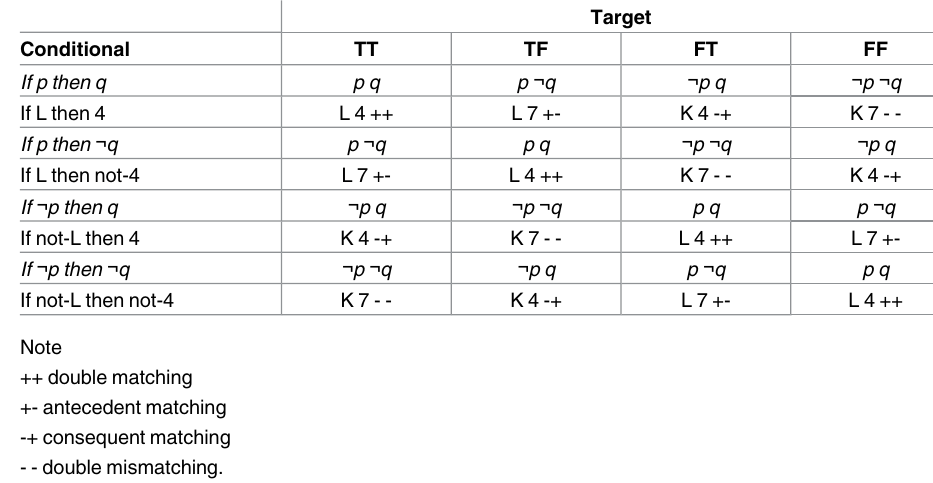
Table 3. A Negated Paradigm of a Conditional With an Example of the Conditional Statements and